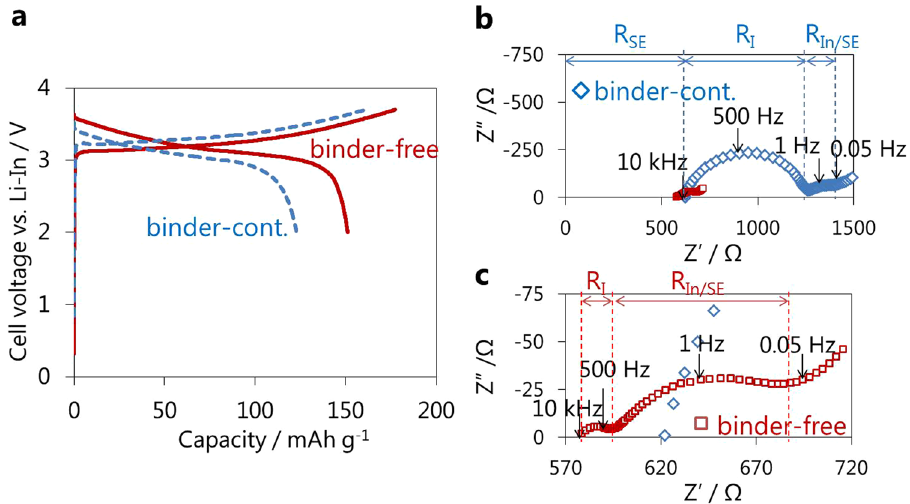
Figure 3. Efficacy of the removal of PPC from positive half-cells. ( a ) Initial charge-discharge curves of binder- free and binder-containing positive half-cells (NCM:f-LPS:AB:PPC = 80:20:2:3)/f-LPS/In operated at a current density of 0.064 mA cm − 2 between the cut-off voltage of 3.7–2.0 V vs. Li-In and ( b ), ( c ) the corresponding impedance plots measured after charging to 3.7 V vs.